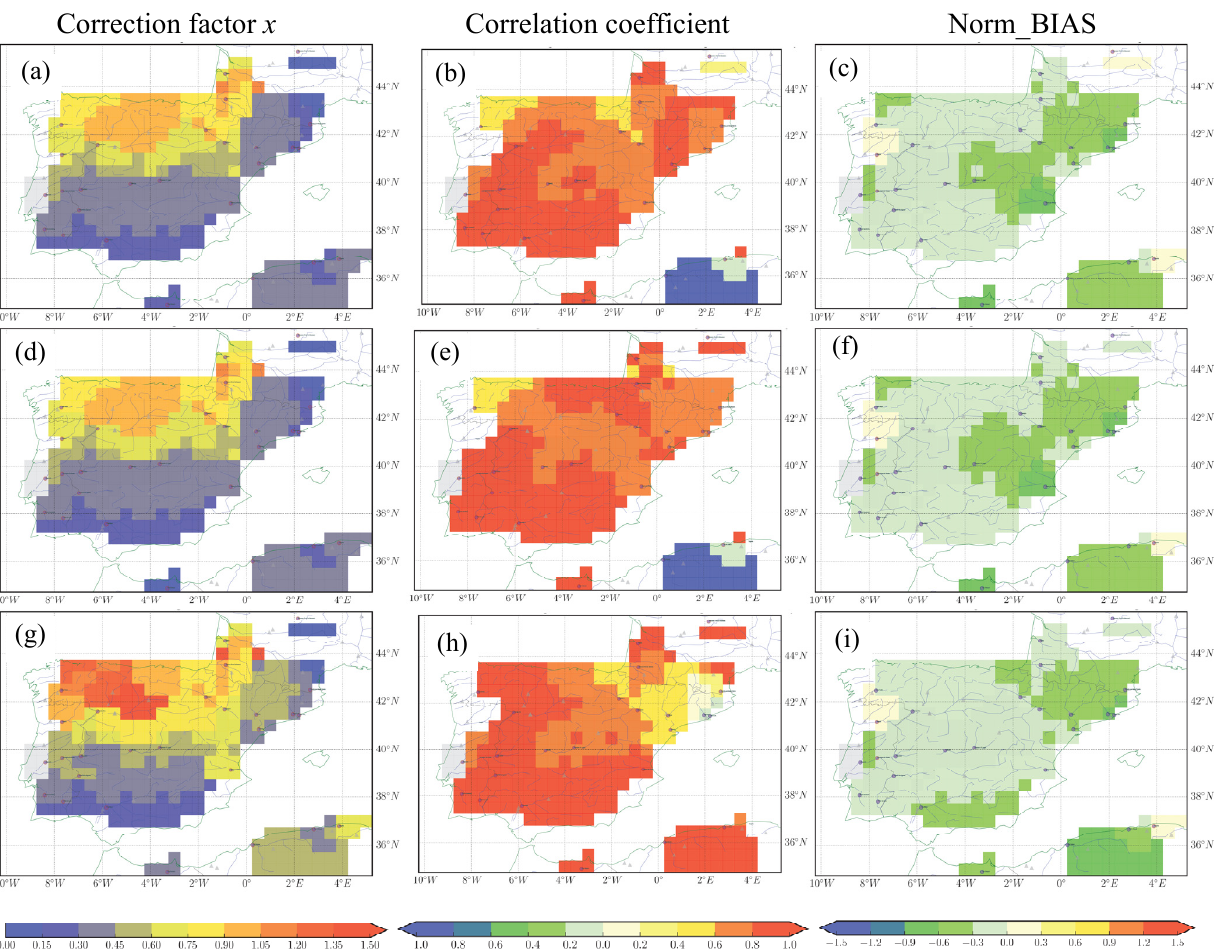
Figure 6. The optimization results from 1980 to 1989 using the three methods (1st row: Y1SP1; 2nd row: Y1SP0; 3rd row: Y10C) forced by WFDEI_GPCC. Left column: the optimized correction factor x ; Middle column: the correlation coefficient of river discharge between observations and optimizations; Right column: the Norm_BIAS of optimized river discharge.